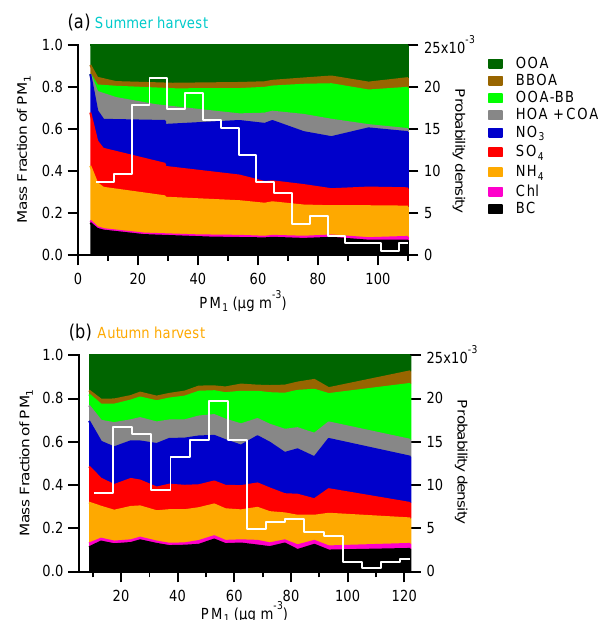
Figure 8. The mass fractions of PM 1 species and OA components as a function of PM 1 mass loadings (left), and probability density of PM 1 mass loadings (right, with the white lines in the plots) during the summer (a) and autumn (b) harvest,